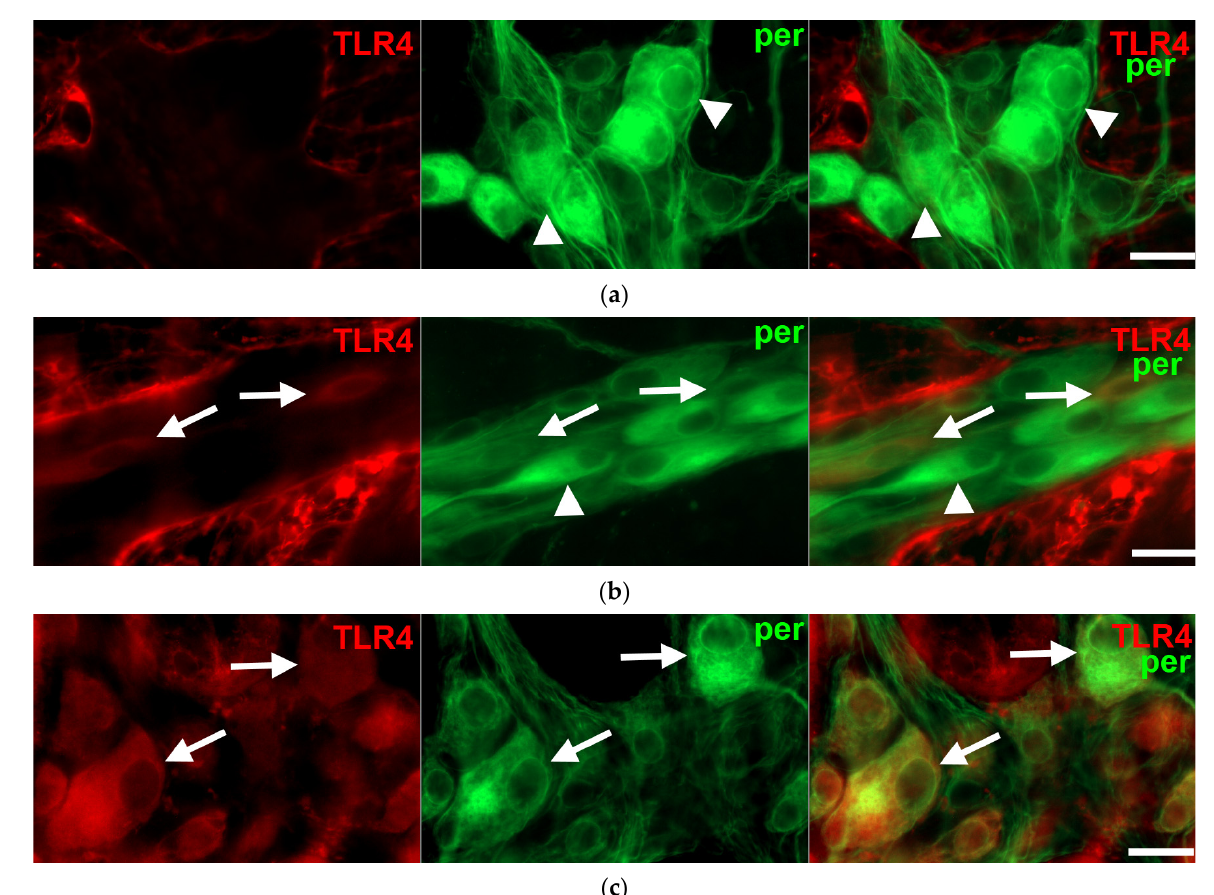
Figure 1. Representative fluorescent micrographs of whole-mount preparations of myenteric ganglia from the duodenum ( a ), ileum ( b ) and colon ( c ) of a control rat after TLR4-peripherin double-labelling immunohistochemistry. Peripherin was used as a pan-neuronal marker to label myenteric neurons. Arrows—TLR4-immunoreactive myenteric neurons, arrowheads—myenteric neuron, scale bars: 20 µm.